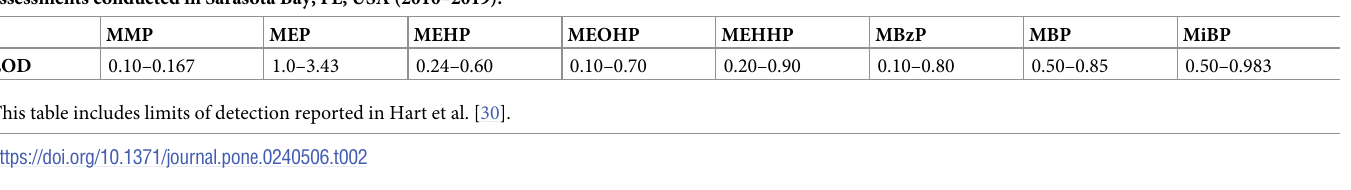
MEHP was the most commonly detected metabolite among sampled bottlenose dolphins overall range of < LOD to 76.60 ng/mL (Table 3). Approximately 29% of screened dolphins had detectable concentrations of MEP, with a geometric mean of 4.51 ng/mL (95% CI: 2.77– 7.34 ng/mL) and range of < LOD to 33.40 ng/mL (Table 3). Natural-log transformed concen- trations of MEP and MEHP were not significantly correlated (r = -0.12; p = 0.41). In fact, only nine of the 28 dolphins (32.14%) with detectable concentrations of MEHP had detectable con- centrations of MEP.